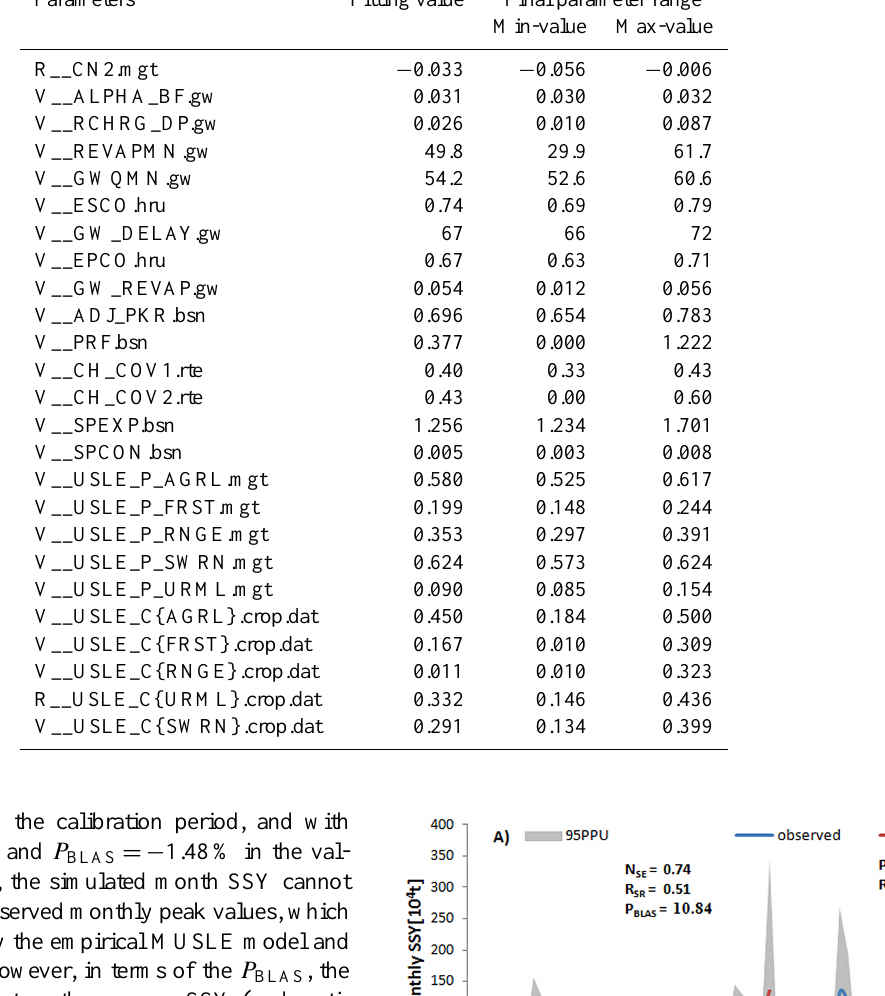
Table 4. The final ranges and fitting values of the SWAT model parameters included in the final calibration procedure. Parameters Fitting value Final parameter range